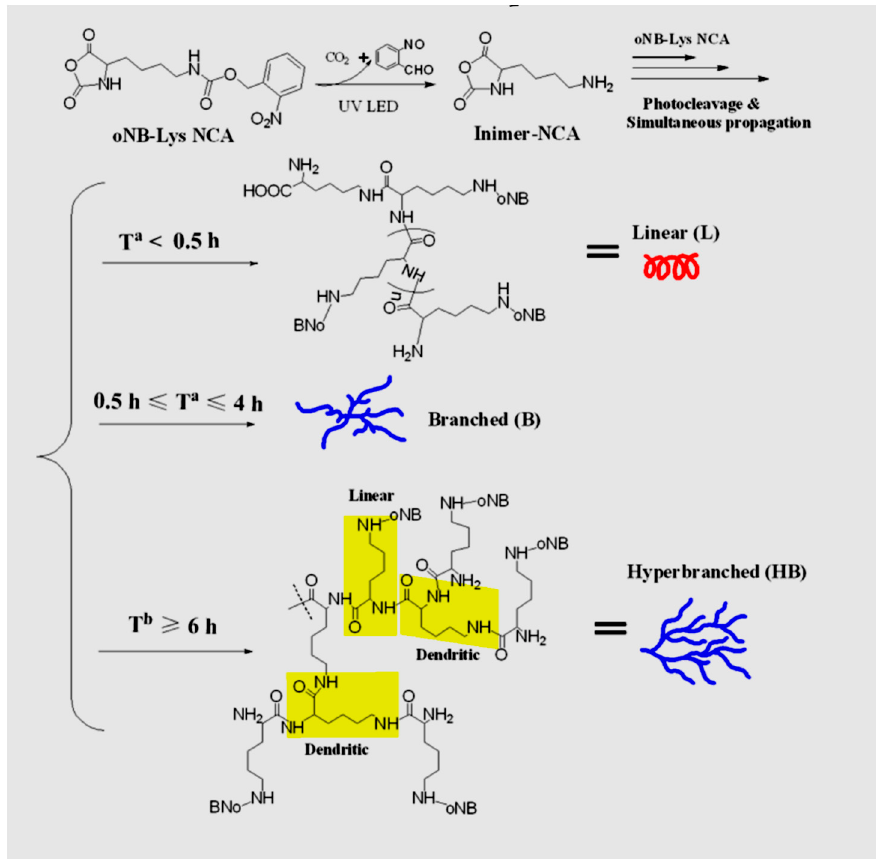
Figure 53. Illustration for UV-Triggered ROP of oNB-LysNCA in One Pot and at Room Temperature. a Polymerize in dark place after initial UV-irradiation. b Consecutive irradiation until complete monomer conversion. Reproduced with permission from reference [225].